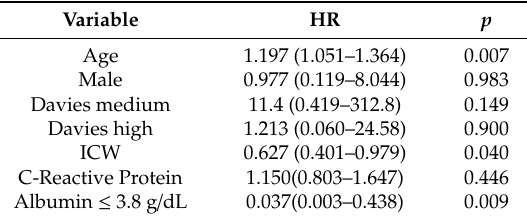
Table 5. Adjusted relative risk of all-cause mortality in 122 prevalent hemodialysis